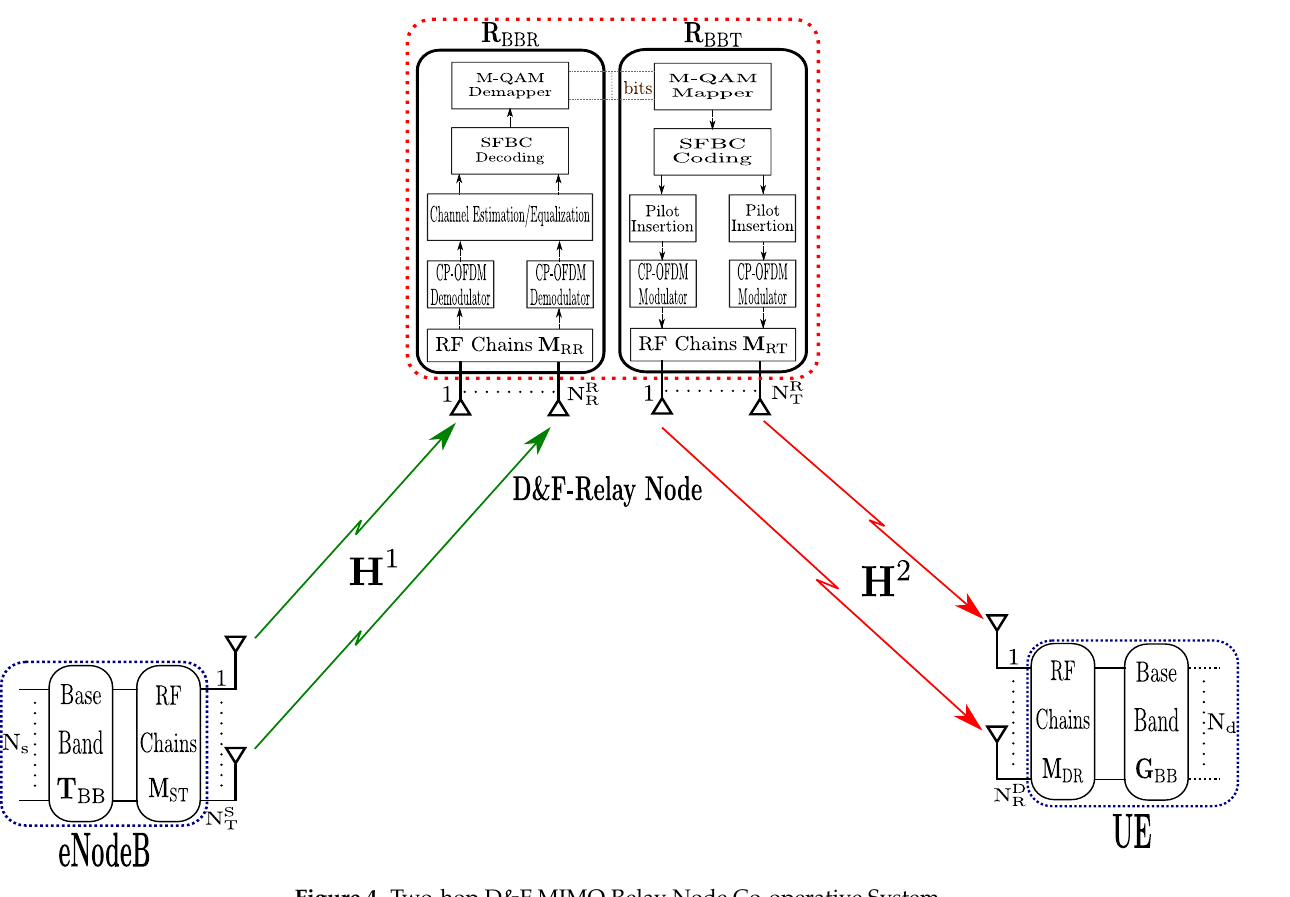
Figure 4. Two-hop D&F MIMO Relay Node Co-operative